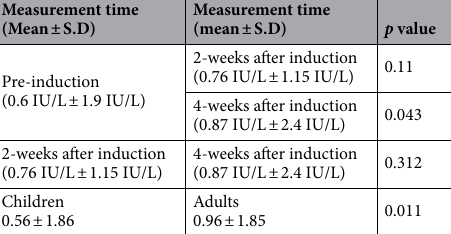
Table 8. The comparison of the mean of total bilirubin before and after induction.